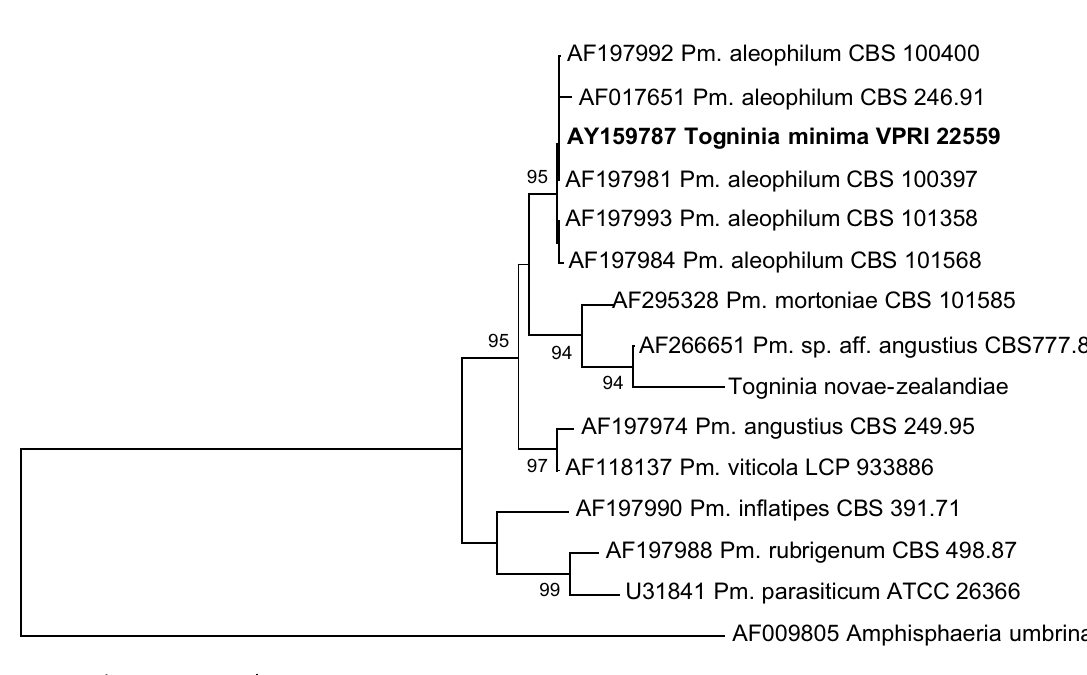
Fig. 1. Phylogenetic tree based on ITS sequences for ex-type cultures of all Phaeoacremonium species, four addition- al isolates of Pm. aleophilum , VPRI 22559 (our Togninia sp.), Togninia novae-zealandiae (from published sequence of Hausner et al . 1992), and CBS 777.83 ( P. sp. aff. angustius ). Bootstrap numbers lower than 90% are not shown.